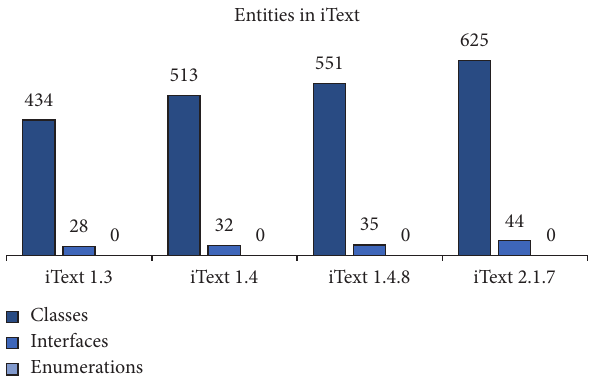
Figure 5: Count of entities in iText.